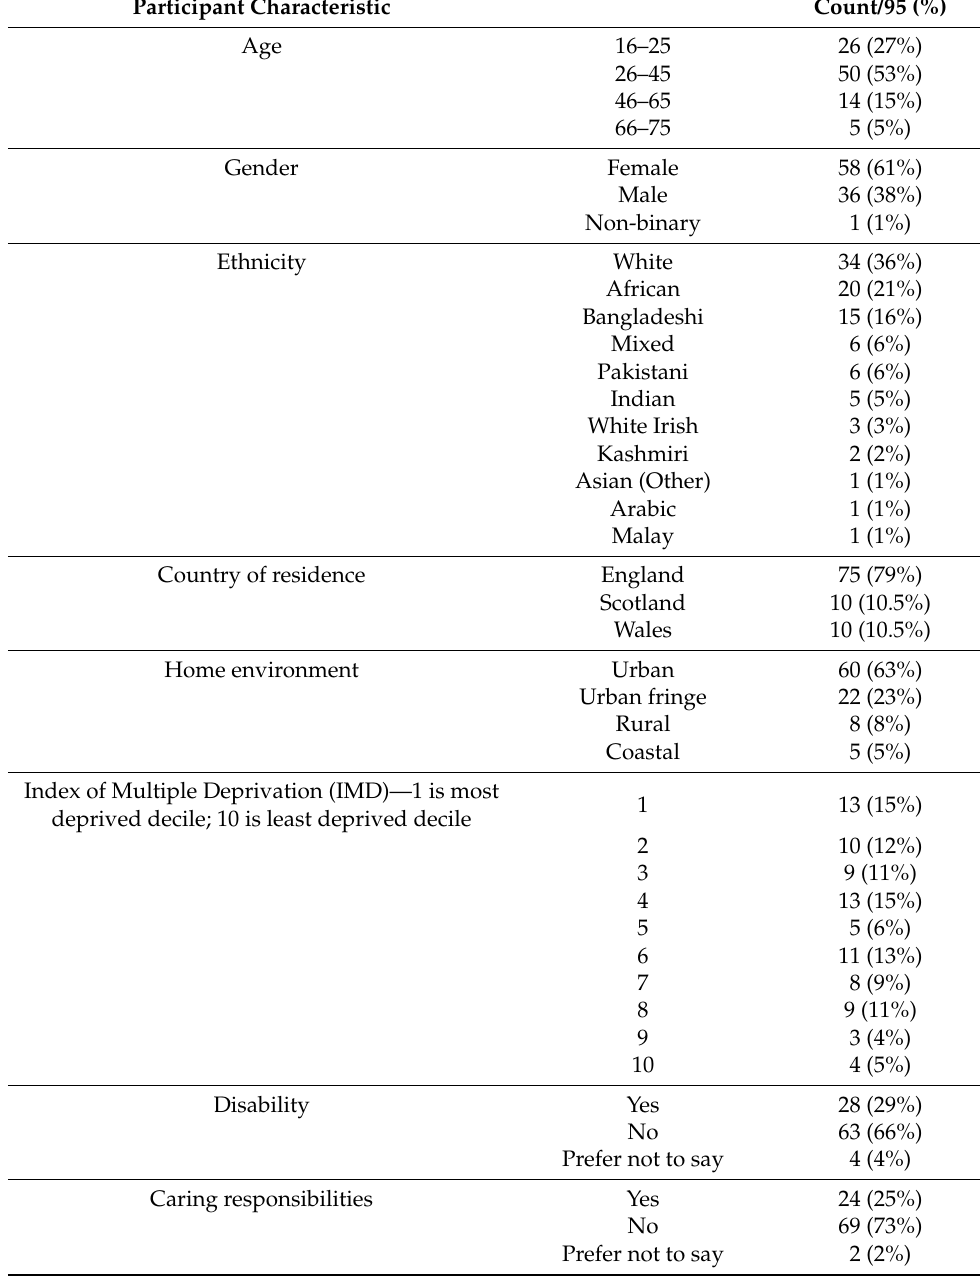
Table 2. Characteristics of study participants as self-reported using an online